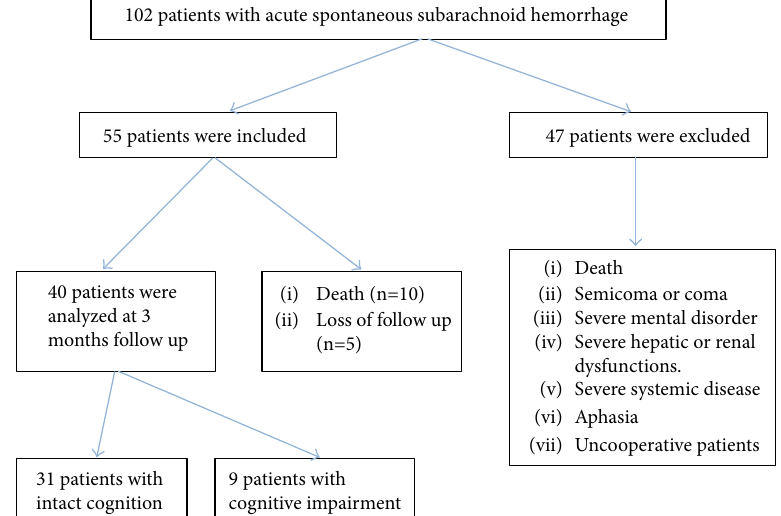
Figure 1: Study fl ow chart of patients included in the fi nal analysis.